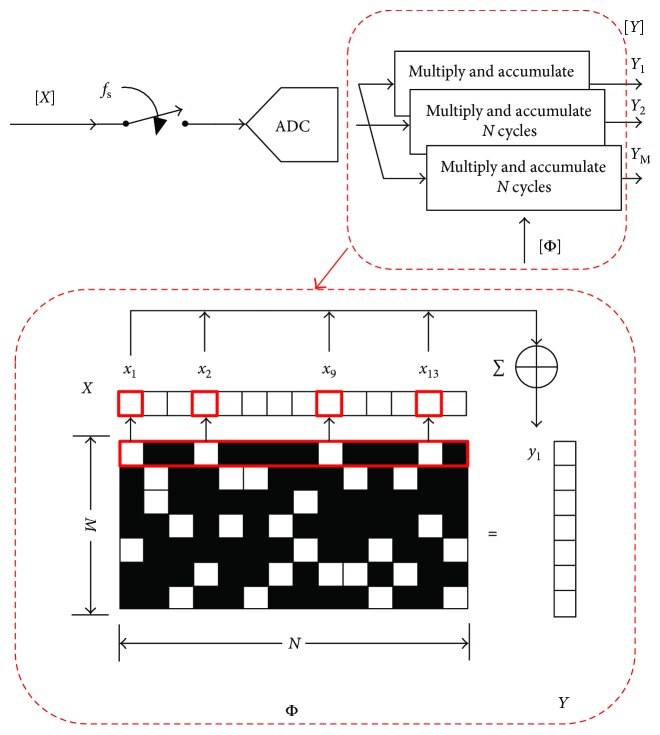
Scheme of digital CS compression on node.